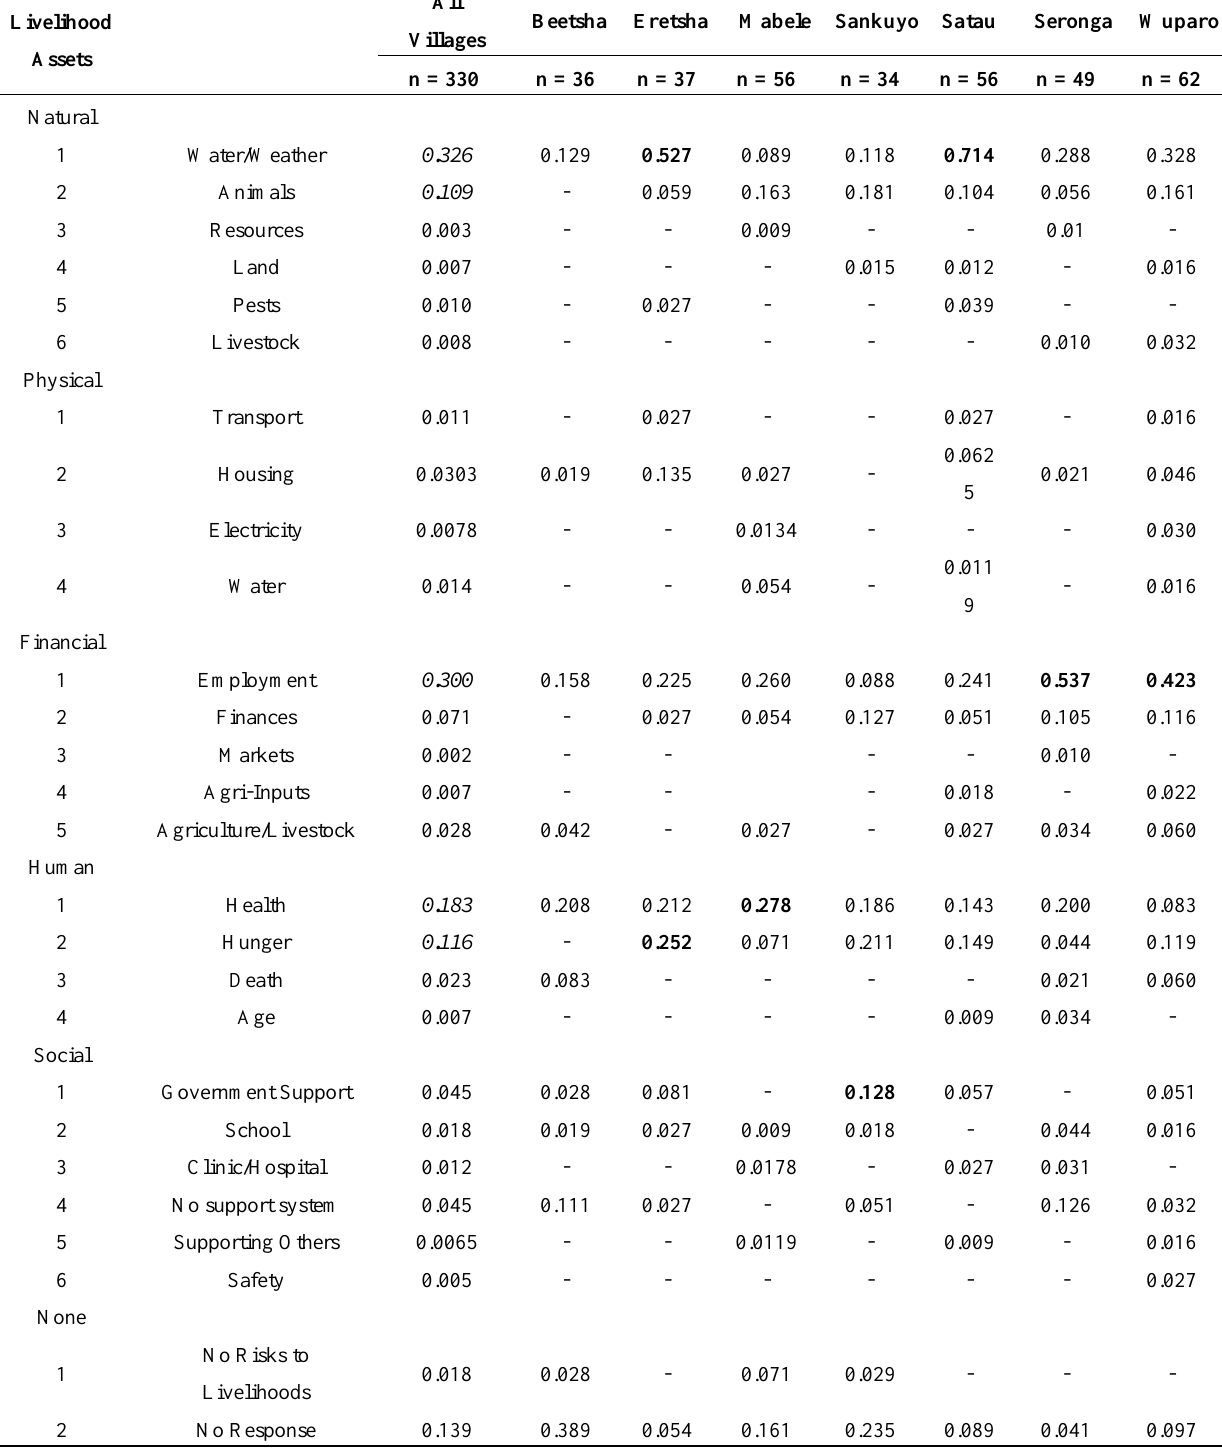
Table 4. Risk index values for the entire sample and by villages. This index ranges from 0 (least risk) to 1 (most severe risk). Where n refers to the number of households surveyed in each village and the bold values represent significantly high values for each village compared to the all village